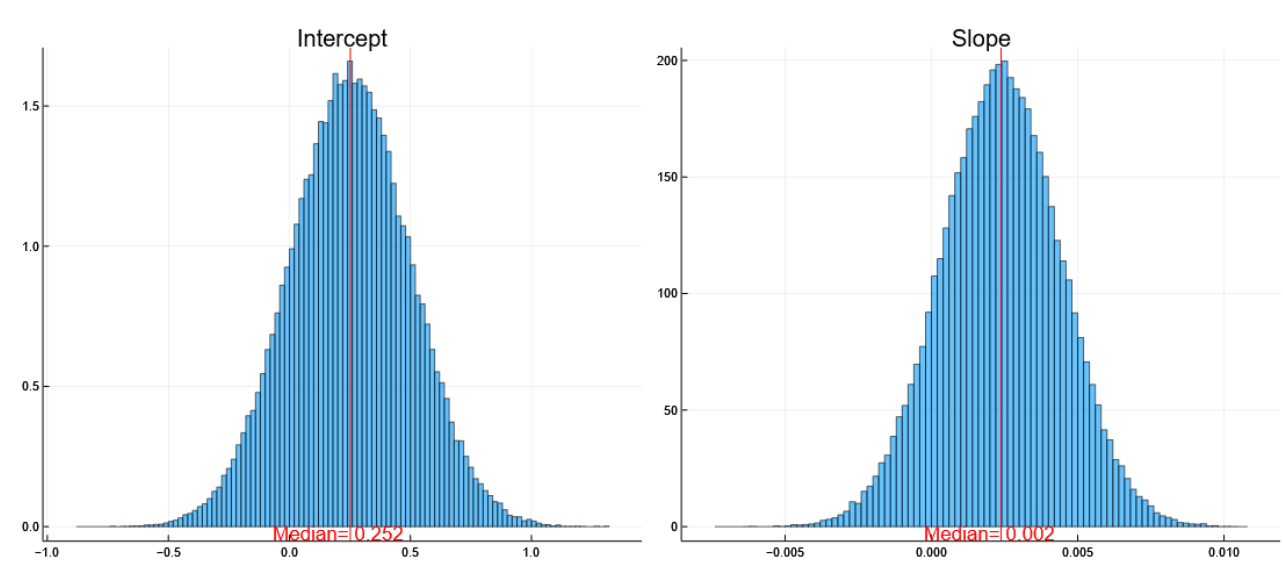
Figure 4. Simulation Regression: Left panel denotes the histogram of the intercept. Right panel denotes the histogram of the slope. Source: